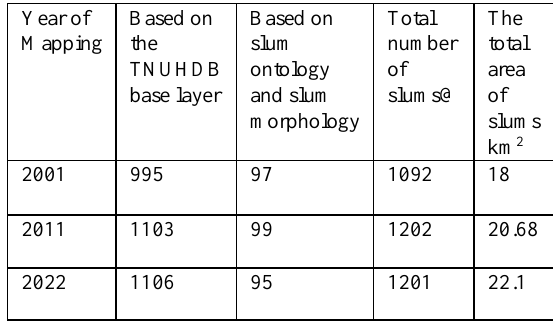
Table 3. Growth of